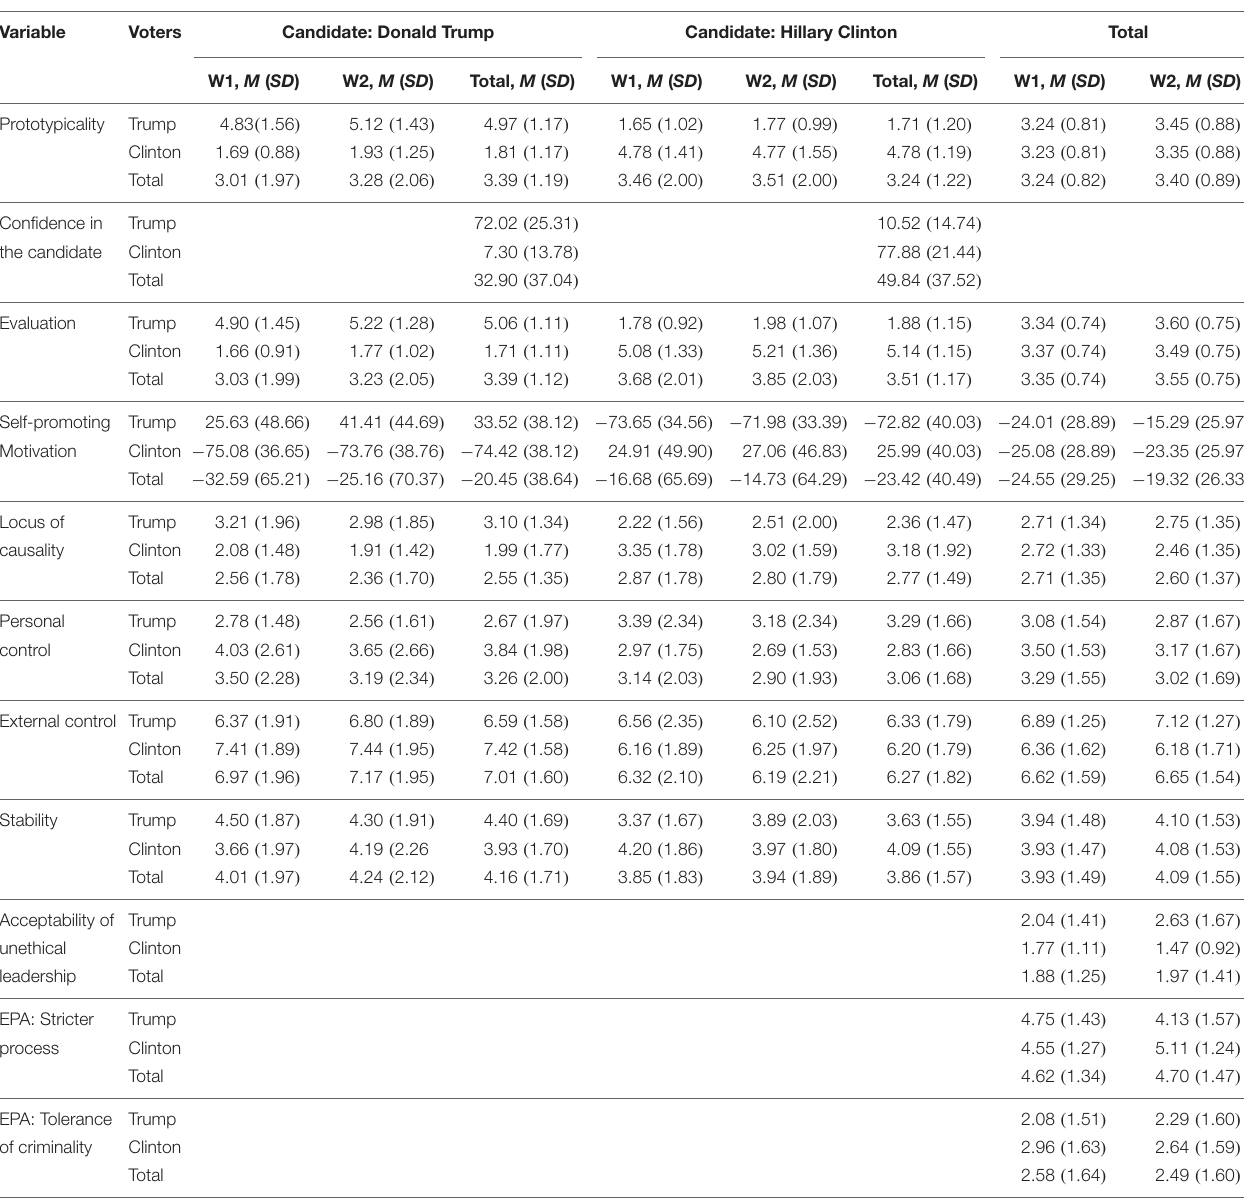
TABLE 1 | Means and standard deviations for all